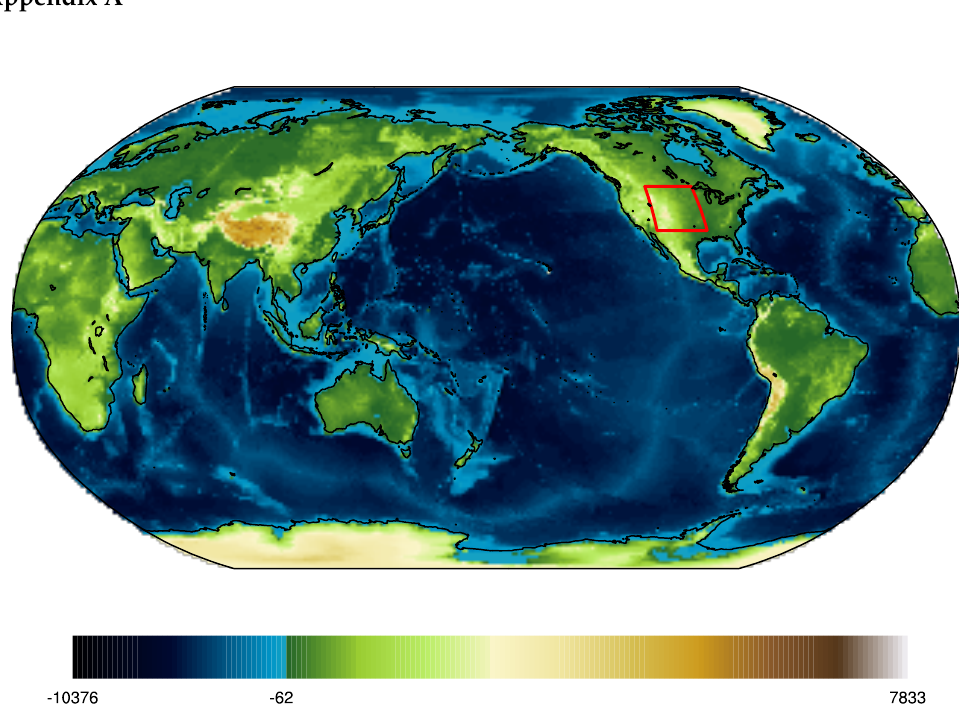
Figure A1. The geographical location of the RRM region ( 32.5 ◦ N to 47.5 ◦ N, 112.0 ◦ W to 92.0 ◦ W). The blue and the green/brown colors indicate the ocean and the orography, respectively (data sources: [80]).